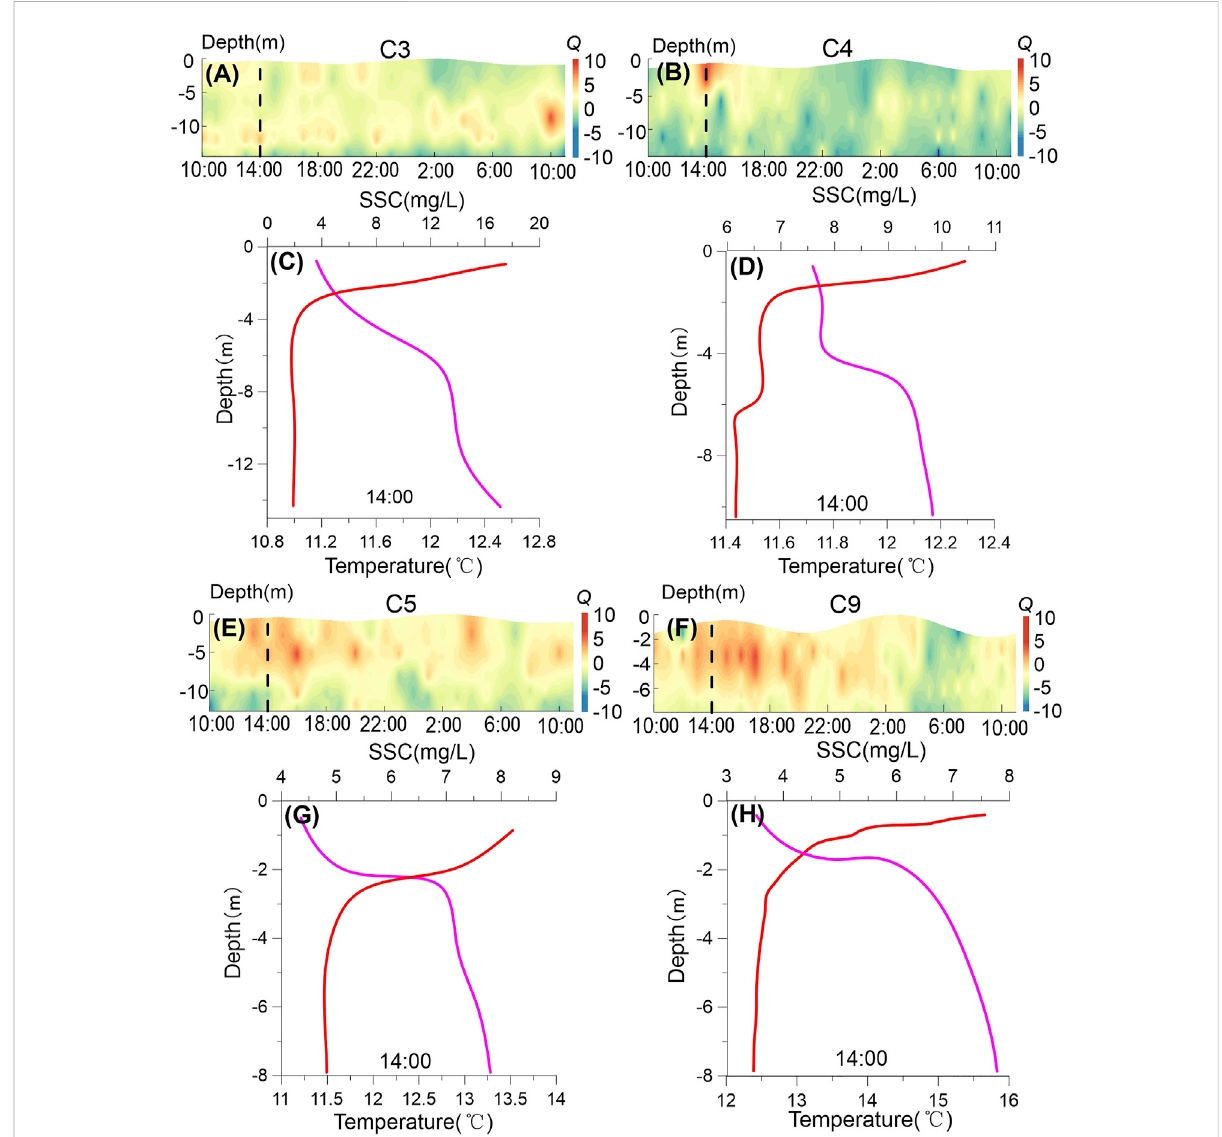
FIGURE 8 The time series diagrams of Q ( Q (cid:1) In ( Rig /0 . 25 ) )during thespring tide (A,B,E,F) , the vertical sectionsof temperature(red line) and SSC (fuchsia line) at typical stations at 14:00 in May 2020 (C,D,G,H)